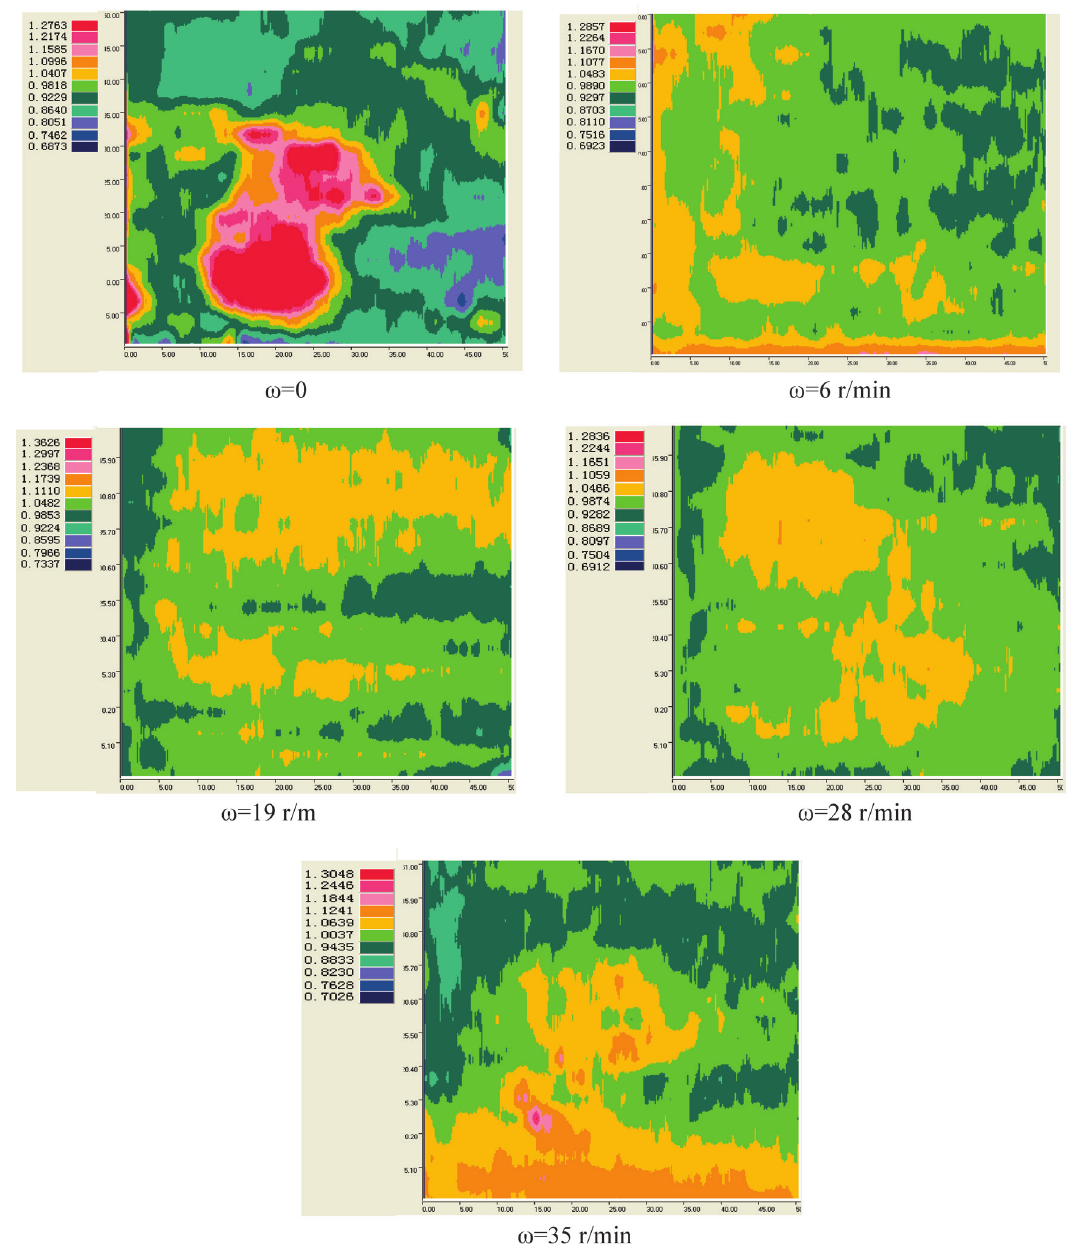
Fig. 3: Effects of mould rotation on carbon